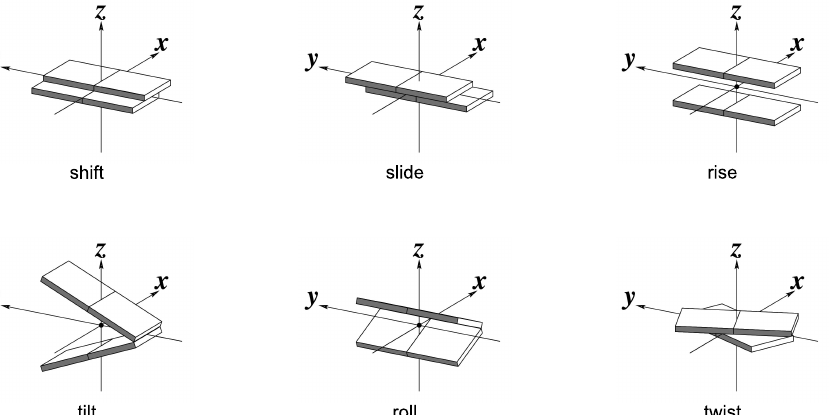
Figure 3. Graphical definitions of rigid-body coordinates used to describe the geometry of sequential base-pair